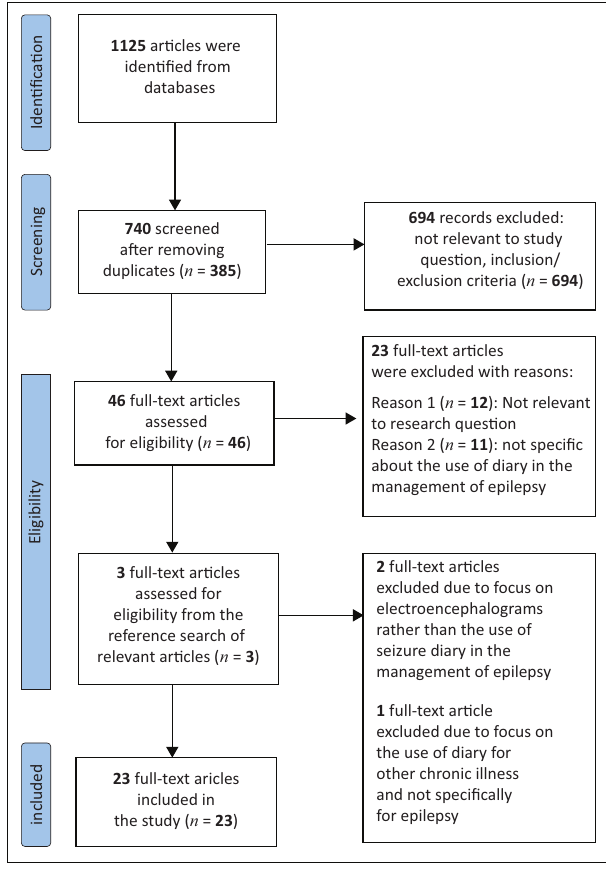
FIGURE 1: Flow chart of article